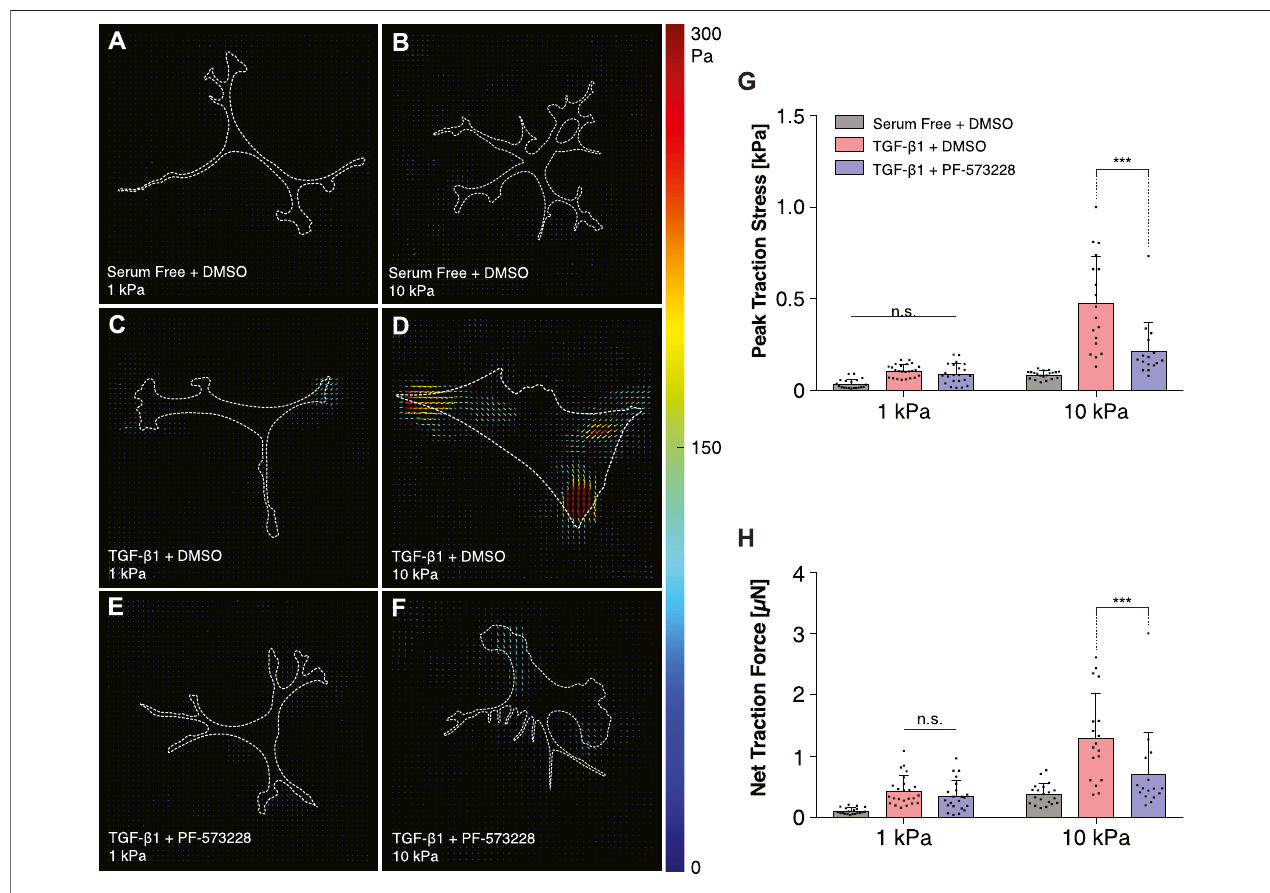
FIGURE 6 | Inhibition of FAK reduces TGF- β 1-induced traction forces on stiff substrata. (A – F) Representative traction stress maps of individual cells cultured on eitherfunctionalized1 kPa (A,C,E) or10 kPa (B,D,F) PAsubstrata.Cellswereculturedineitherserum-freeconditions (A,B) orinmediacontainingTGF- β 1 (C – F) ,andin either the presence (E,F) or absence (A – D) of the FAK inhibitor, PF-573228. (G,H) Quanti fi cation of peak traction stress (G) and net traction force (H) . Error bars represent mean ± s.d. for at least n = 16 cells from 5 experimental replicates. A two-way ANOVA with a Tukey post-hoc test was used to evaluate signi fi cance among groups. (***, p <